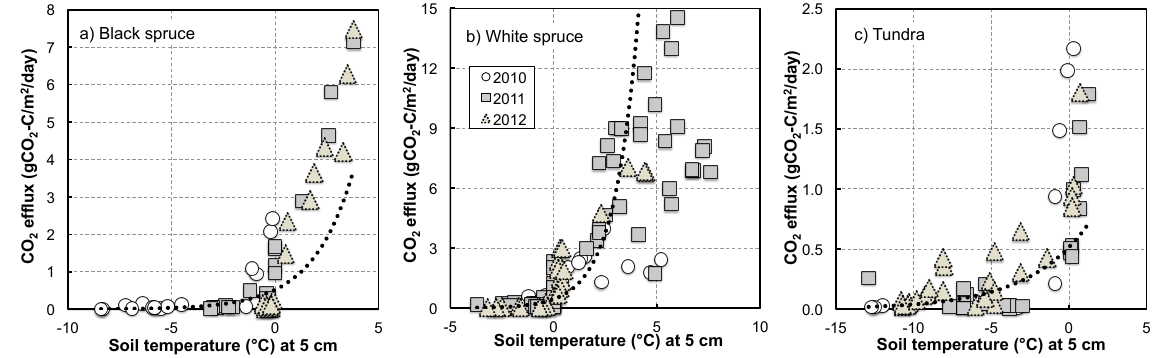
Figure 3. Spring CO 2 efflux responses to soil temperature at 5 cm below the surface at (a) black spruce forest sites; (b) white spruce forest sites; and (c) tundra sites, during the spring of 2010–2012. Dotted curves denote the 3-year exponential relationship between spring CO 2 efflux and soil temperature.